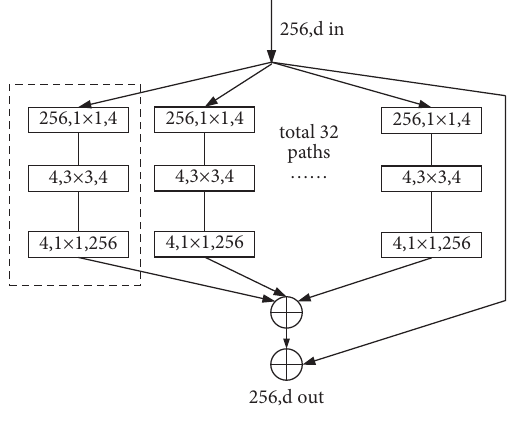
Figure 2: ResNeXt block.